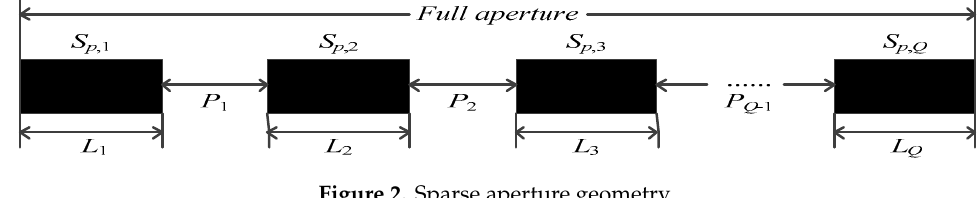
Figure 2. Sparse aperture geometry.